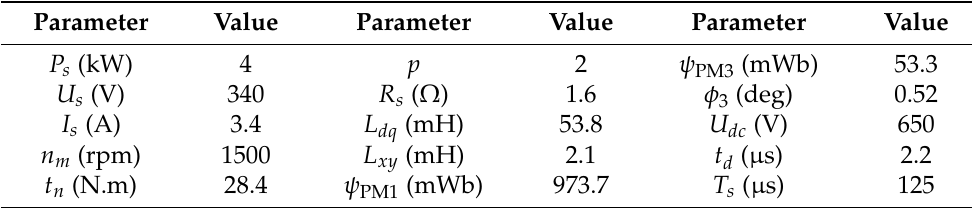
Table 1. Parameters of the six-phase PMSM